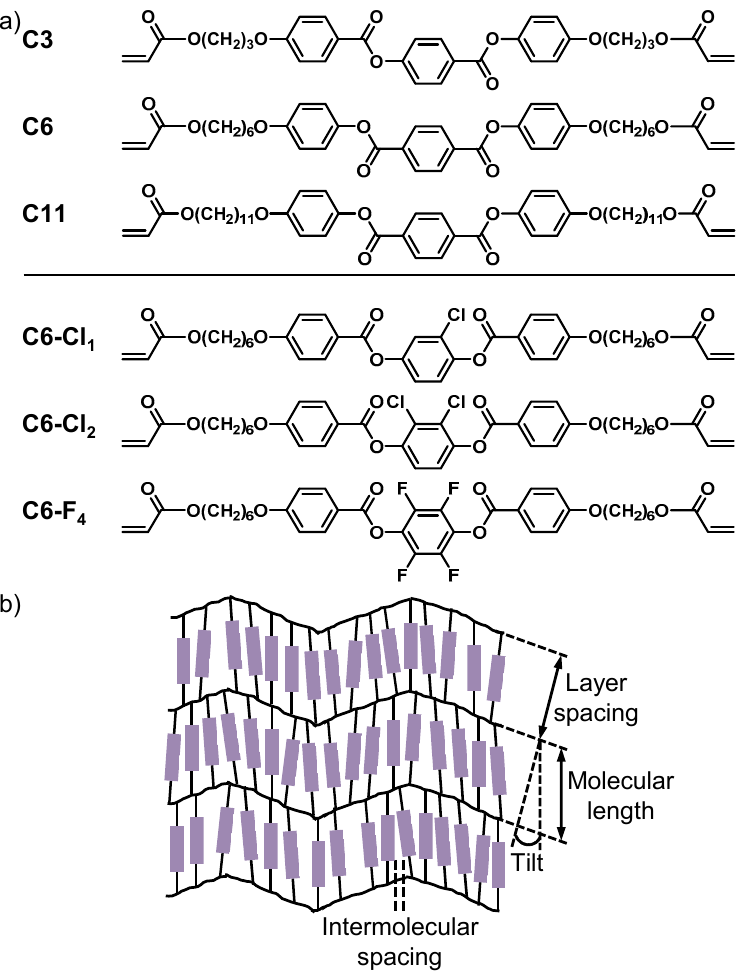
Figure 1. ( a ) Chemical structures of the LCs used in this research. ( b ) Artist impression of a top view of the planar aligned smectic C membranes, which shows the layer spacing, molecular length, intermolecular spacing and tilt angle of the LC molecules. The purple rods represent the aromatic cores of the